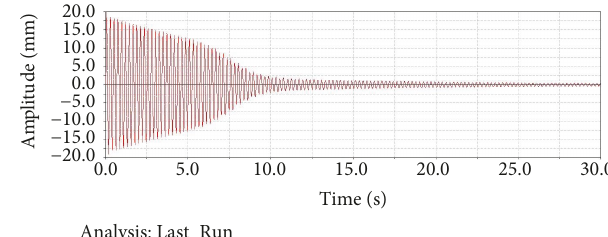
Figure 11: Vibration response of the flexible arm under the fre- quency ratio of 2.2 :1.